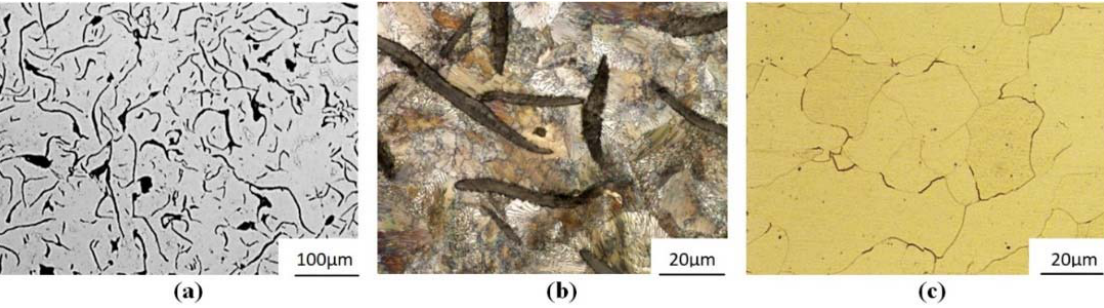
Figure 3. Alloys: ( a ) No. 6 cast iron GJL ‐ 300—eutectic colonies of IA3/4 graphite; ( b ) No. 6 cast iron GJL ‐ 300 — pearlitic matrix, straight graphite IA3/4 (S C = 0.98) and ( c ) No 7 —ferritic structure of Armco iron; ( a ) unetched; ( b , c ) etched with Mi1Fe.